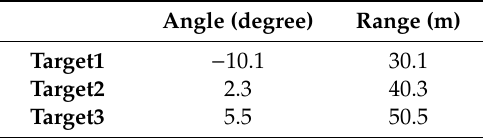
Table 2. Simulated target